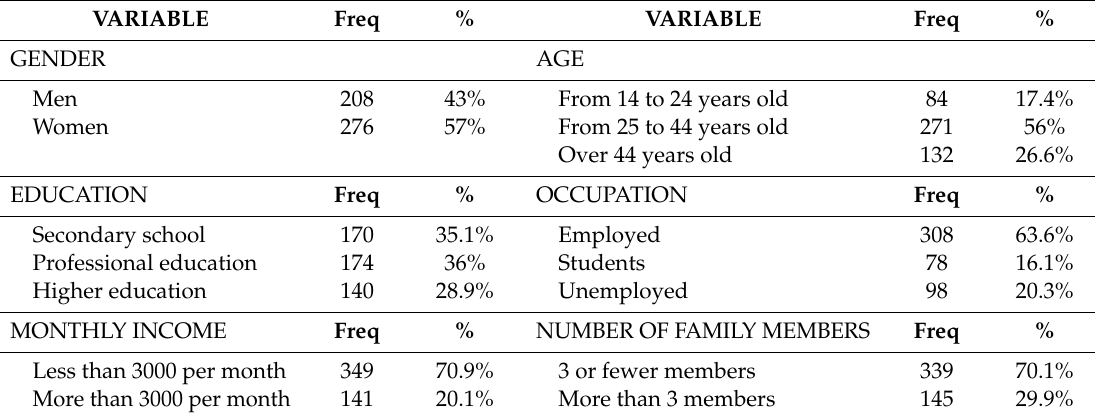
Table 3. Recoding sociodemographic variables and profile of the